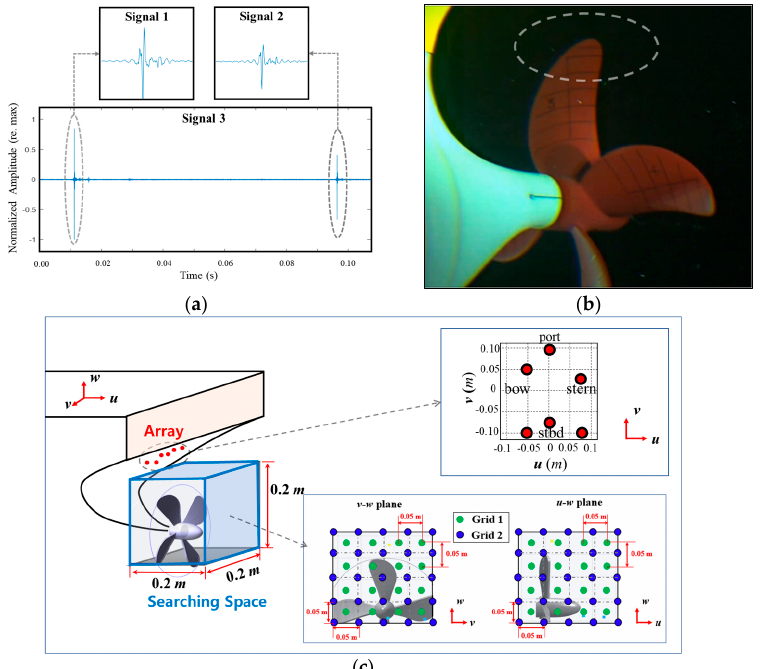
Figure 10. ( a ) Measured time signal involving two different impulsive cavitation noises. ( b ) Visual observation of the cavitation tunnel experiment. The rate of revolution of the propeller, and cavita- tion number were set as 0.65 (cid:3400) 10 (cid:2873) Pa, 1390 rev/min, and 4.12, respectively. ( c ) Configuration of six hydrophones and the search space for TVC